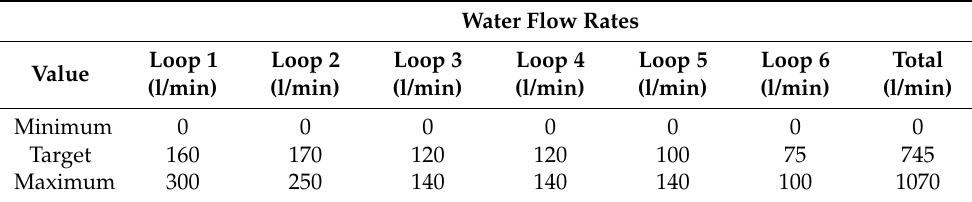
Figure 6. Considered target temperature distribution along the CCM for the steel grade 18CrNiMo7-6, with the longitudinal temperature profiles depicted in the middle of strand faces T SR (small radius), T LR (large radius), T Left (left side), T Right (right side) and T Centre being the temperature in the core of strand. Table 1. Considered target water flow rates in the secondary cooling zone for given casting speed 2.78 m/s.